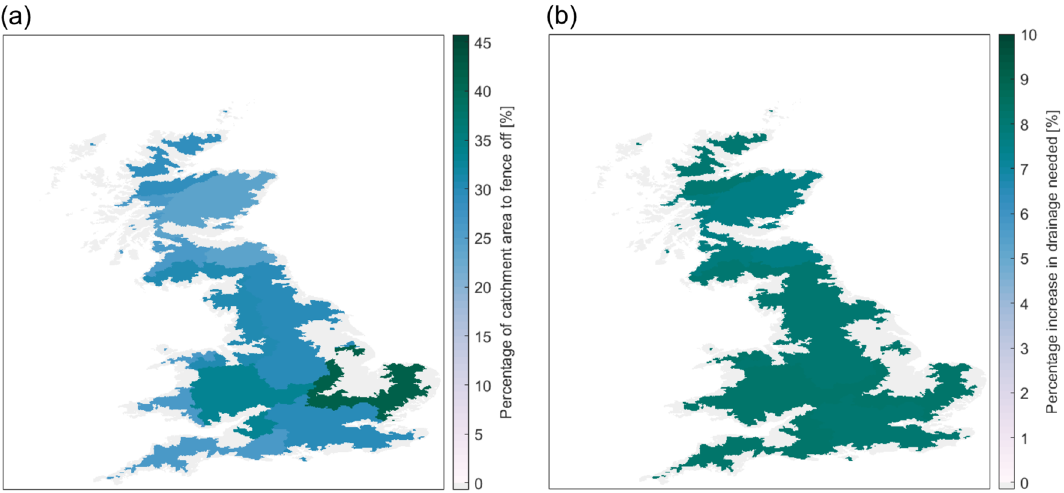
Figure 4. Effectiveness of environmental interventions (maps created using Matlab R2019a): ( a ) Percentage of catchment area we would have to exclude from livestock grazing to reduce summer risk of infection by at least the same percentage achieved using treatment (on average across catchments within each region and for year 2013 as an example within our simulation period—but also see Figure S2 for a comparison with a wetter year); ( b ) Percentage increase in drainage that would be needed, compared to current conditions, to match as close as possible the reduction in summer risk of infection achieved using treatment (on average across catchments within each